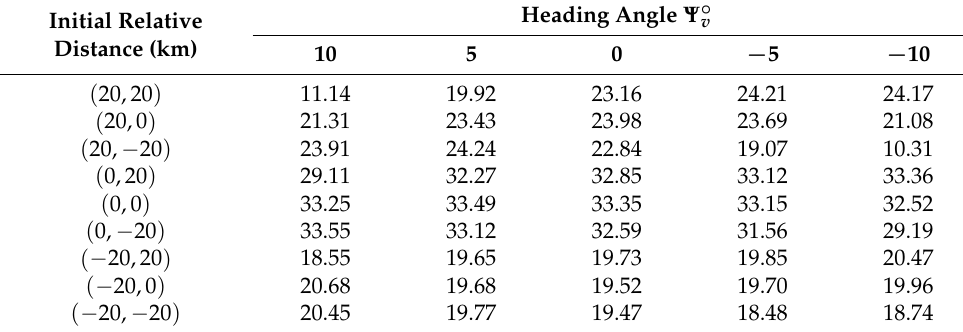
Table 8. Miss distance (m) with initial flight path angle θ = − 5 ◦ .